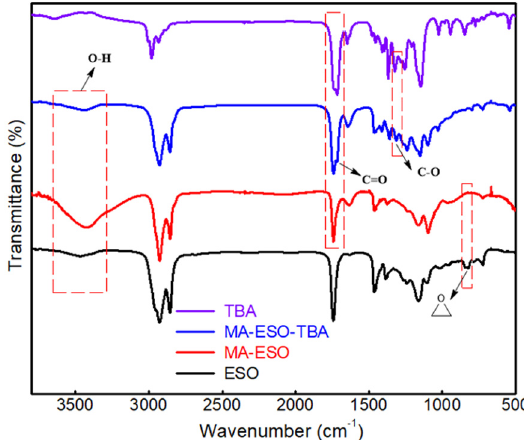
Figure 2. FTIR characterization of acetoacetylated soybean oil.